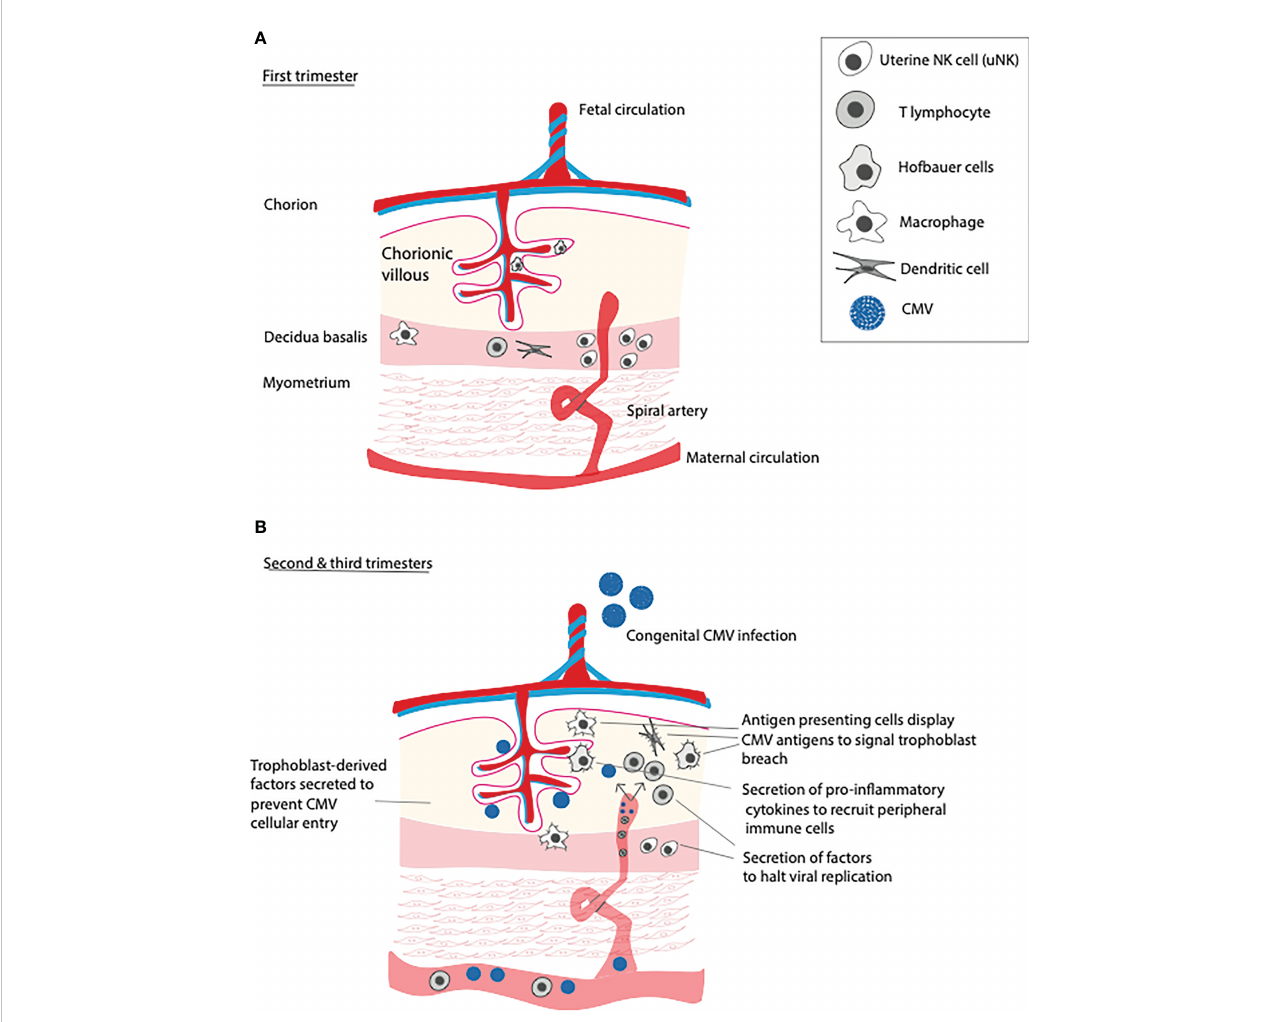
FIGURE 1 Immune function of the placenta over gestational time and in response to primary CMV infection. (A) In the fi rst trimester, uterine NK cells (uNK) remodel spiral arteries and defend against viral infections that threaten to invade into the chorionic villi. (B) In the second and third trimesters, numbers of uNK cells dwindle, leading increased placental susceptibility to primary CMV infection. Upon infection, placental T cells and antigen presenting cells (APCs) incudling dendritic cells, macrophages, and Hofbauer cells, recruit peripheral T lymphocytes, inducing placental in fl